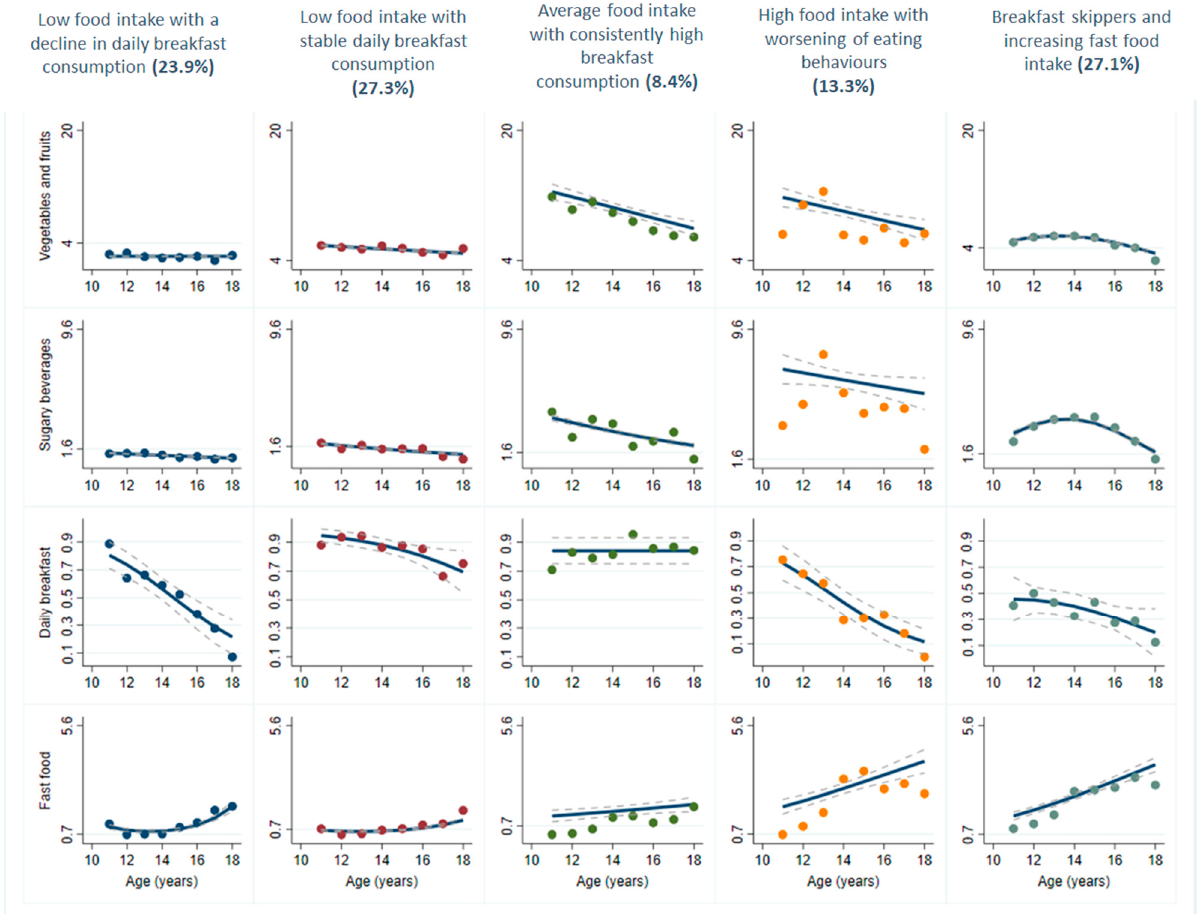
Figure 2. Multi-trajectory modelling of four eating behaviours among adolescent boys in the MATCH study. Figure caption: MATCH: Monitoring Activities of Teenagers to Comprehend their Habits. Dashed line represents the 95% confidence interval. Solid lines represent the average frequency of daily intakes for vegetables and fruits, sugary beverages and fast food, and the probability of daily breakfast consumption.